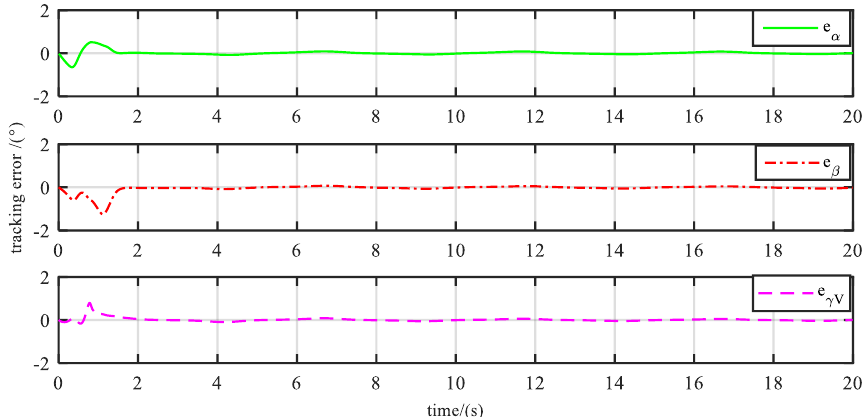
Figure 5. Tracking errors. It takes a little longer to learn to control the sideslip angle and bank angle than the attack angle. This can be attributed to the stronger coupling characteristics between the roll and yaw channels.